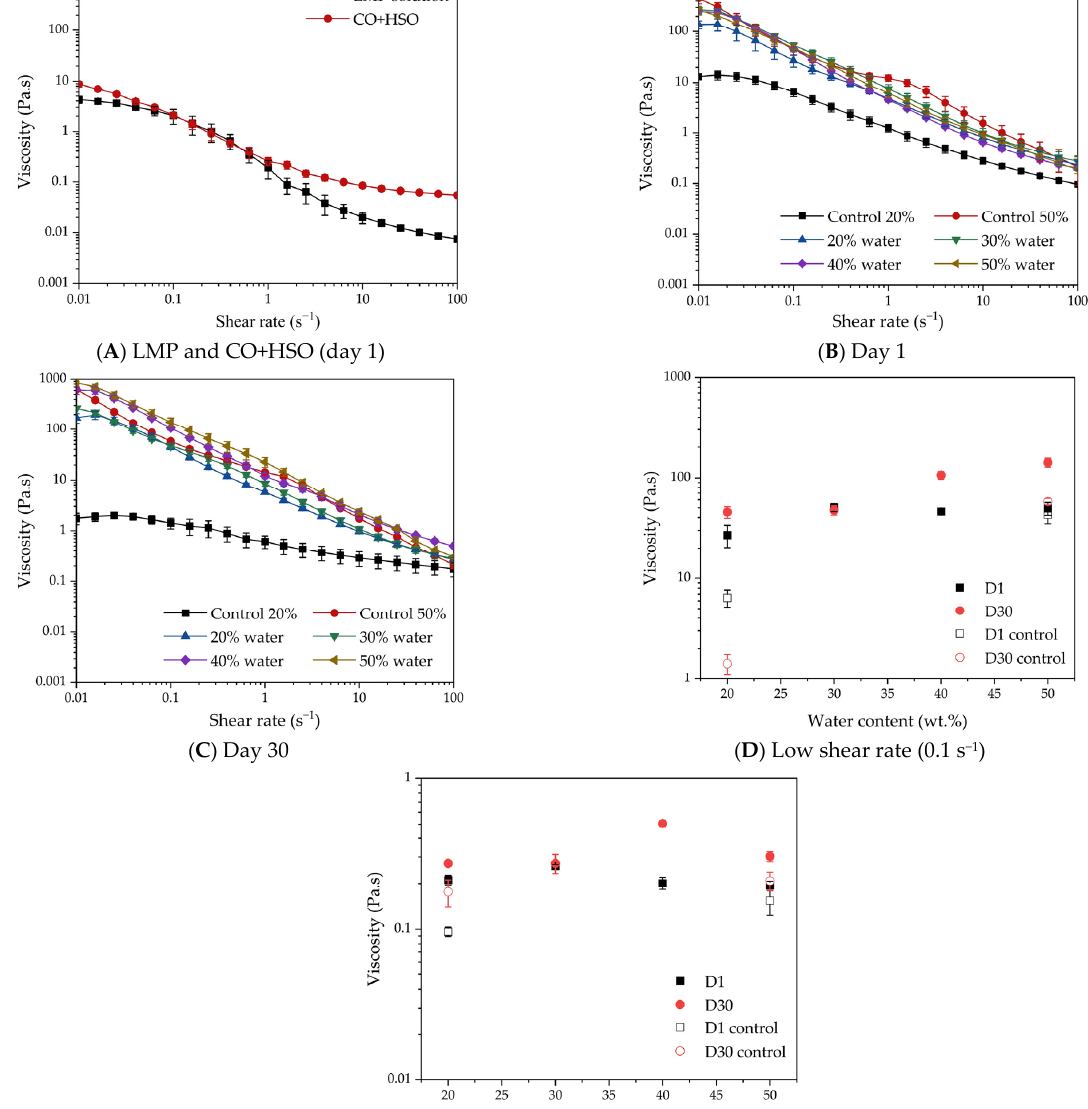
Figure 2. Apparent viscosity of 1.5 wt.% LMP solution and 7 wt.% HSO in canola oil on day 1 ( A ). Viscosity as a function of shear rate for water-in-oil emulsions with different water contents of 20, 30, 40, and 50 wt.%, prepared with and without LMP, GMO, and HSO on day 1 ( B ) and day 30 ( C ). Apparent viscosity of water-in-oil emulsions with different water contents of 20, 30, 40, and 50 wt.%, prepared with and without LMP, GMO, and HSO on day 1 and day 30, at low (0.1 s − 1 ) shear rate ( D ) and at high (100 s − 1 ) shear rate ( E ). Note the difference in y-axis scales due to the variation in shear rates.